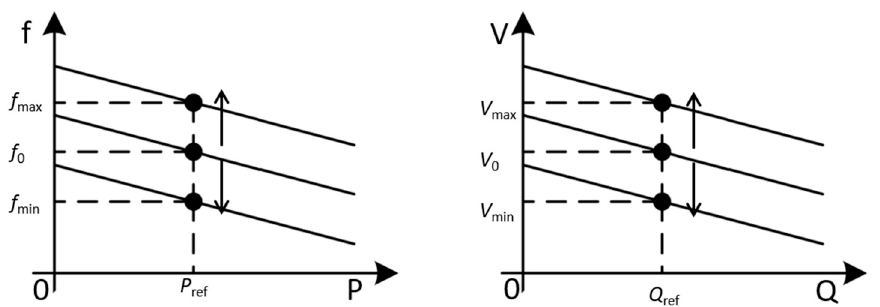
Figure 6. PQ control.